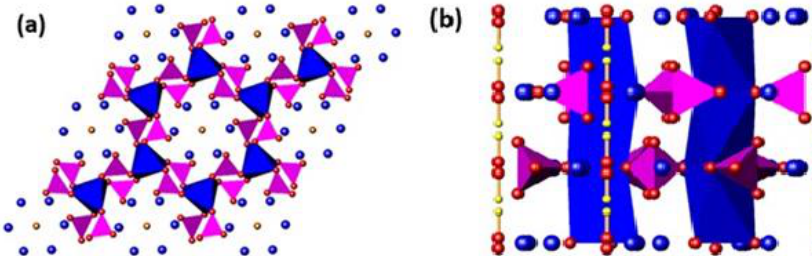
Figure 1. A polyhedral representation of the HA (Ca 10 (PO 4 ) 6 (OH) 2 ) structure projected along the ( a ) [001], and ( b ) [100] directions. The [001] projection highlights the PO 4 tetrahedra (purple) corner-shared to Ca I O 6 metaprisms (blue). The channel OH − units are surrounded by Ca II cations (blue spheres). The [100] projection emphasizes the linear disposition of OH − units in the apatite channel (red and yellow spheres).